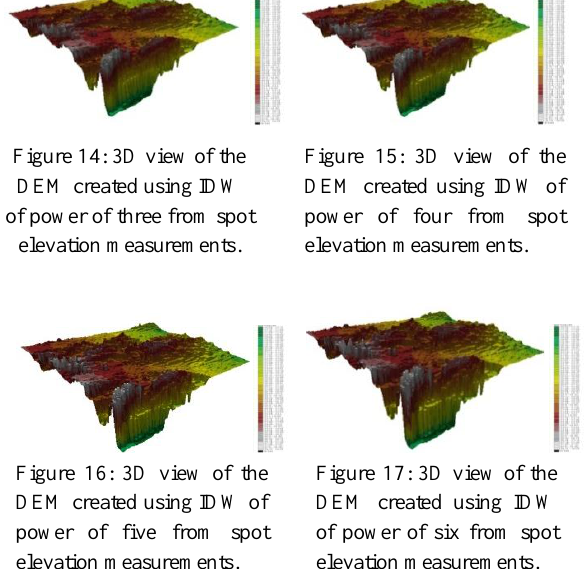
Figure 17: 3D view of the DEM created using IDW of power of six from spot elevation measurements.